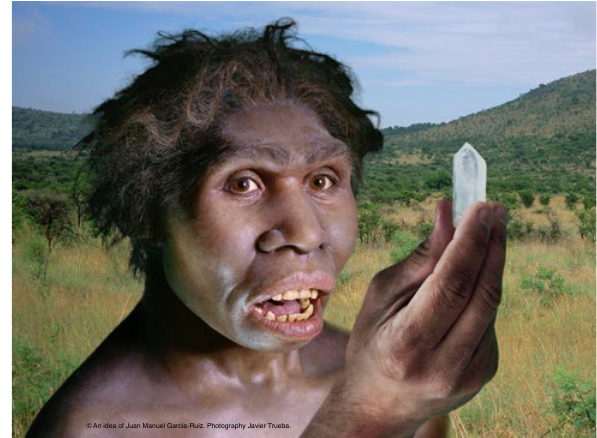
Figure 3. A recreation of the collection of crystals by Homo erec- tus. ©Javier Trueba/Juan Manuel García-Ruiz. With